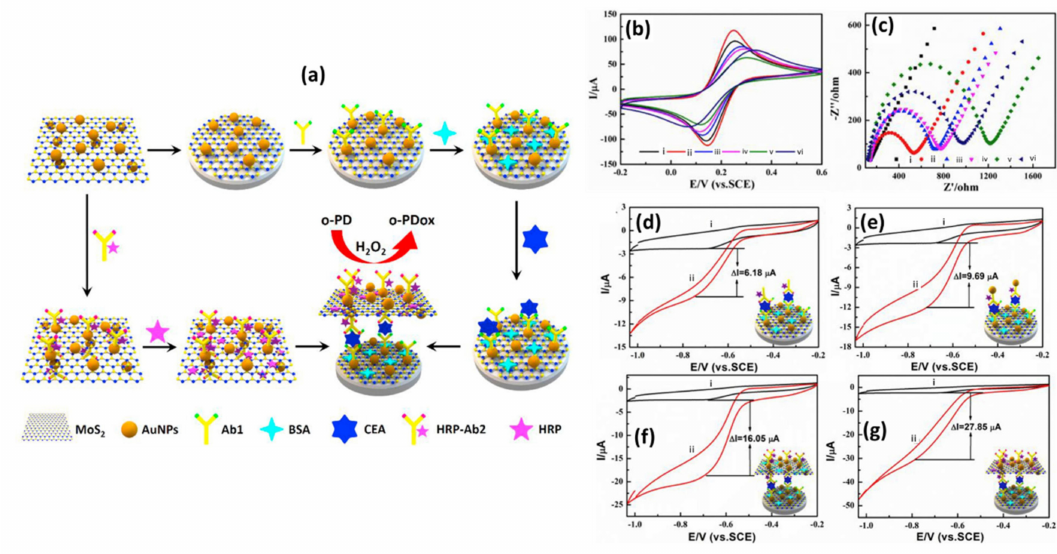
Figure 11. ( a ) Schematic representation of MoS 2 -Au-based immunosensor for CEA detection and signal response mechanism. ( b ) CV and ( c ) EIS curves of (i) bare GCE, modified GCE (ii) MoS 2 -Au, (iii) anti-CEA/MoS 2 -Au, (iv) BSA/anti-CEA/MoS 2 -Au, (v) CEA/BSA/anti-CEA/MoS 2 -Au and (vi)